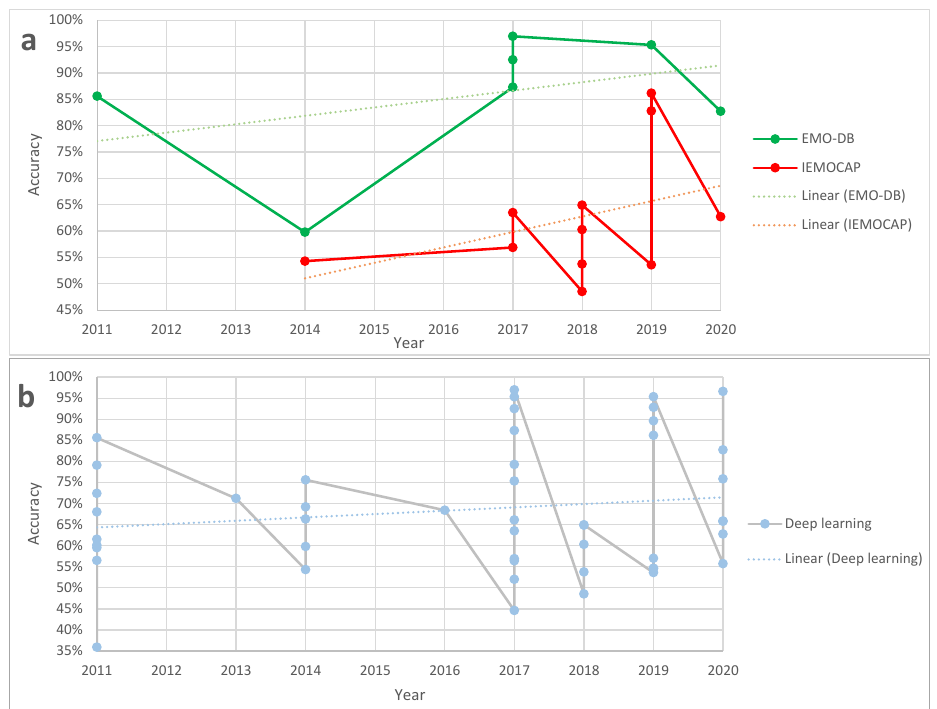
Figure 2. ( a ) Comparison of reported accuracies based on EMO-DB, IEMOCAP, and all databases used in deep learning methods and their trend lines. Dots in solid lines are showing all the accuracies reported and the dotted line shows the linear trendline of reported accuracies. ( b ) Aggregation of all the accuracies reported in deep learning